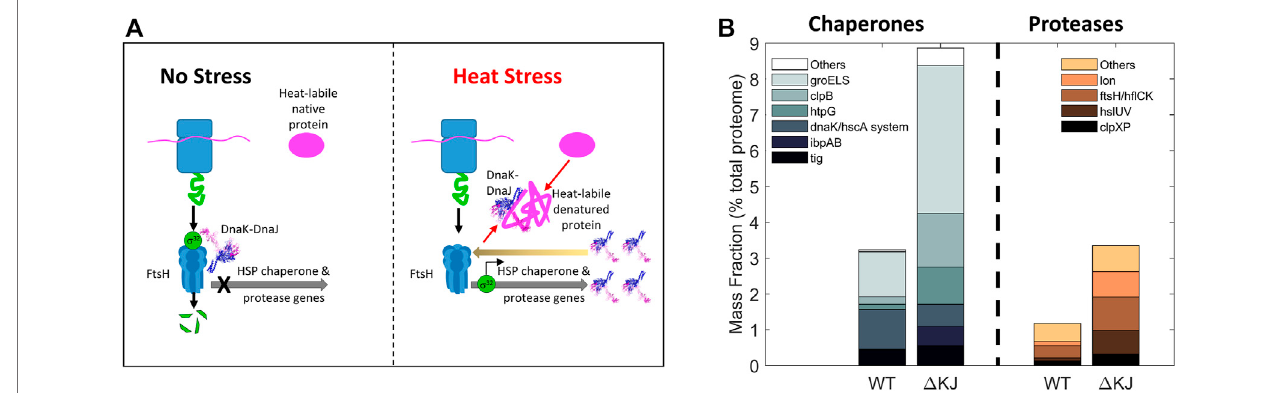
FIGURE5 | Collaboration between Hsp70 and a protease. (A) Bacterial mechanism for theheat-induced expression HSP-chaperones and proteases. Left : In the absence of stress, the transcription factor σ 32 is bound by DnaK/DnaJ as is presented to the protease FtsH to be rapidly degraded, thereby preventing σ 32 -mediated transcription of heat-shock genes. Right : under heat stress, misfolded heat-labile proteins recruit DnaK/DnaJ (thick black arrows) and thus displace them from binding to σ 32 , allowing ittoaccumulate and resulting intheup-regulationofheat-shockproteins.The resulting excess ofDnaKmay then cause the degradation of σ 32 and arrest excess HSP synthesis (back arrow). (B) Deletion of DnaK-DnaJ upregulates the steady state cellular levels of the chaperone-base repair and protease-based degradation machineries. Mass fraction (% of total proteome) of the chaperone and co-chaperones (left) and of proteases (right) in wild type and a delta DnaK-DnaJ E. coli strain. Protein quantities are shown as mass fractions (in % of the total proteome) of individual bacterial molecular chaperones and proteases (Data from (Fauvet et al.,